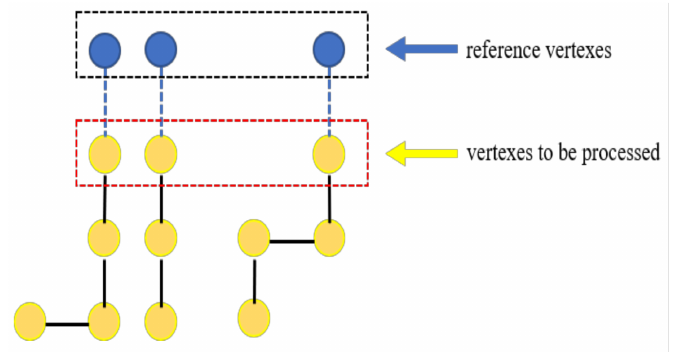
Figure 6. The subtrees used for normal propagation.